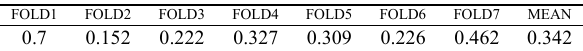
Table 12. RMS errors for the 7 folds (fuzzification parameters defined by the GA).